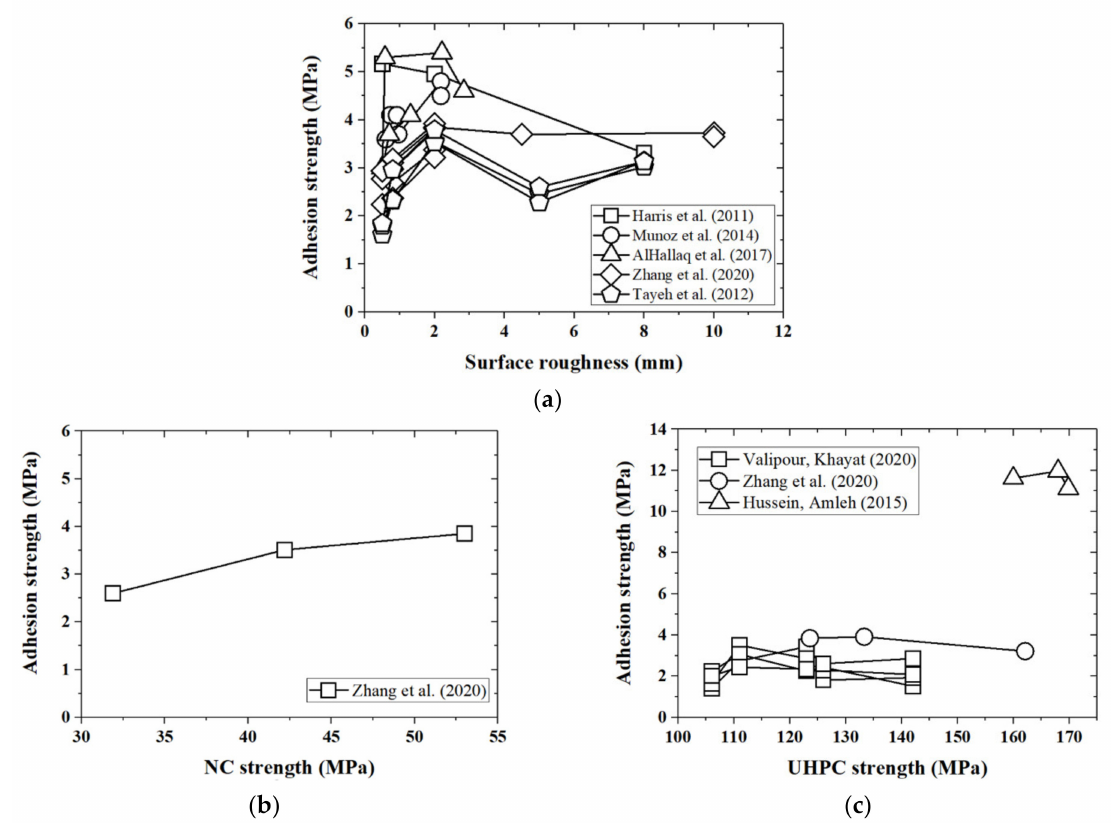
Figure 3. Relations between adhesion and different factors in the splitting test. ( a ) Adhesion and surface roughness; ( b ) adhesion and NC strength; ( c ) adhesion and UHPC